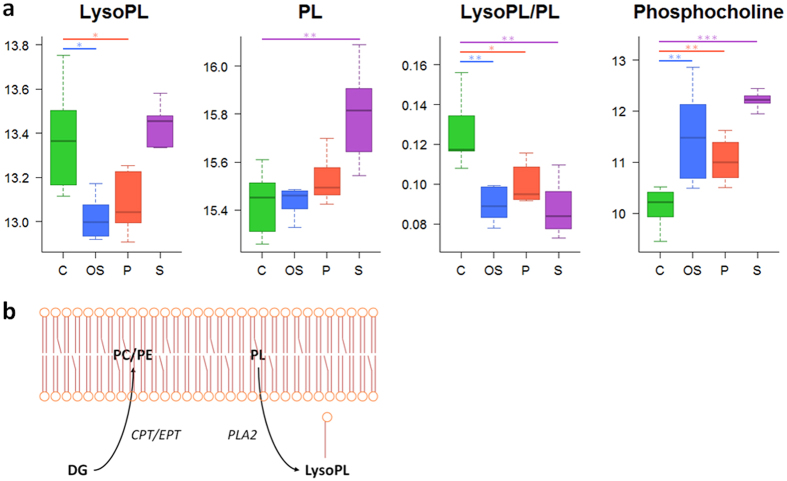
Metabolic alterations related to phospholipid metabolism.(a) Boxplots showing the altered metabolites. Boxes denote interquartile ranges, lines denote medians and whiskers denote the 10th and 90th percentiles. Metabolite relative abundance, expressed as ratio or log-transformed, is calculated by referring metabolite peak intensity to a constant concentration of internal standard per mg of tissue. Green: control (C); blue: oxidative stress (OS); red: phospholipidosis (P); purple: steatosis (S). *, q value < 0.05; **, q value < 0.01; ***, q value < 0.001 calculated using the Mann Whitney test corrected for multiple testing by using FDR. (b) Phospholipid synthesis, via the Kennedy pathway, and degradation, through the action of phospholipase A2 (PLA2). PC: phosphatidylcholine; PE: phospohatidylethanolamine; phospholipid, DG: diacylglyceride; CPT: 1,2-diacylglycerol cholinephosphotransferase; EPT: 1,2-diacylglycerol ethanolaminephosphotransferase.